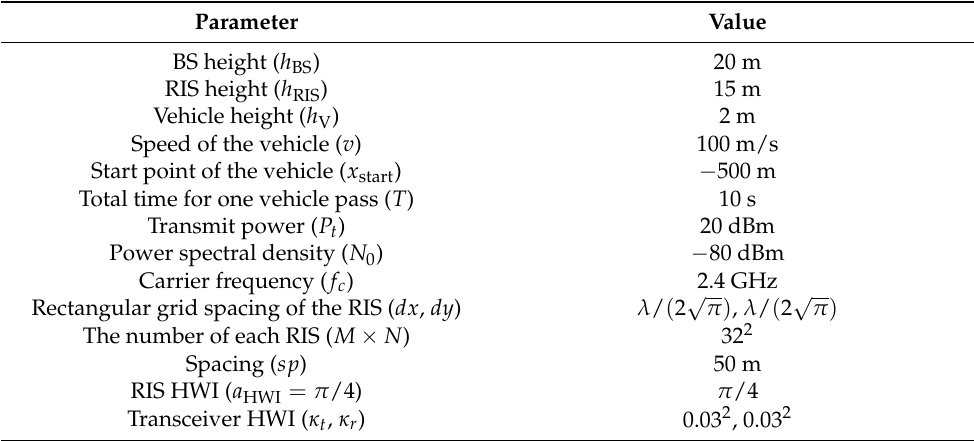
Figure 2. Top view of the multi-RIS system considered in this section. Table 5. Parameter settings